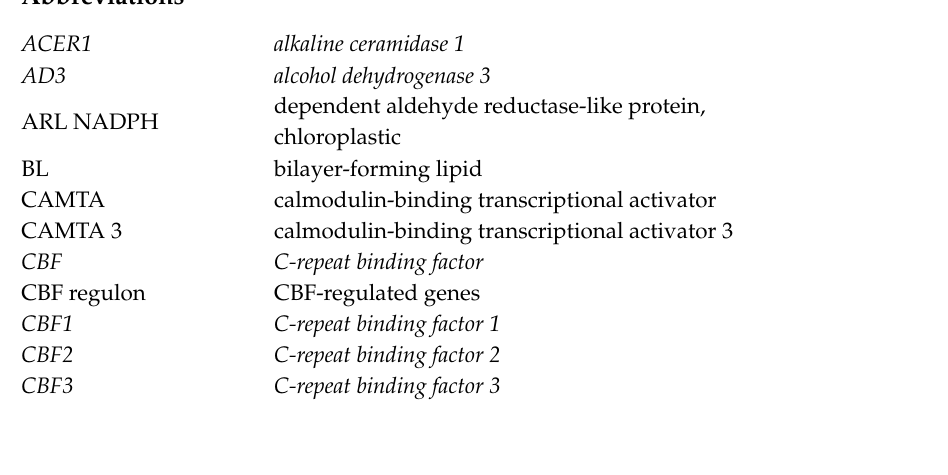
Table S1: Primer sequences and references, Table S2: PC / PE ratio were calculated as described in the Materials and Methods. Significance levels in tables are designated as ** p < 0.05. Mean ± SD values were calculated from three independent biological